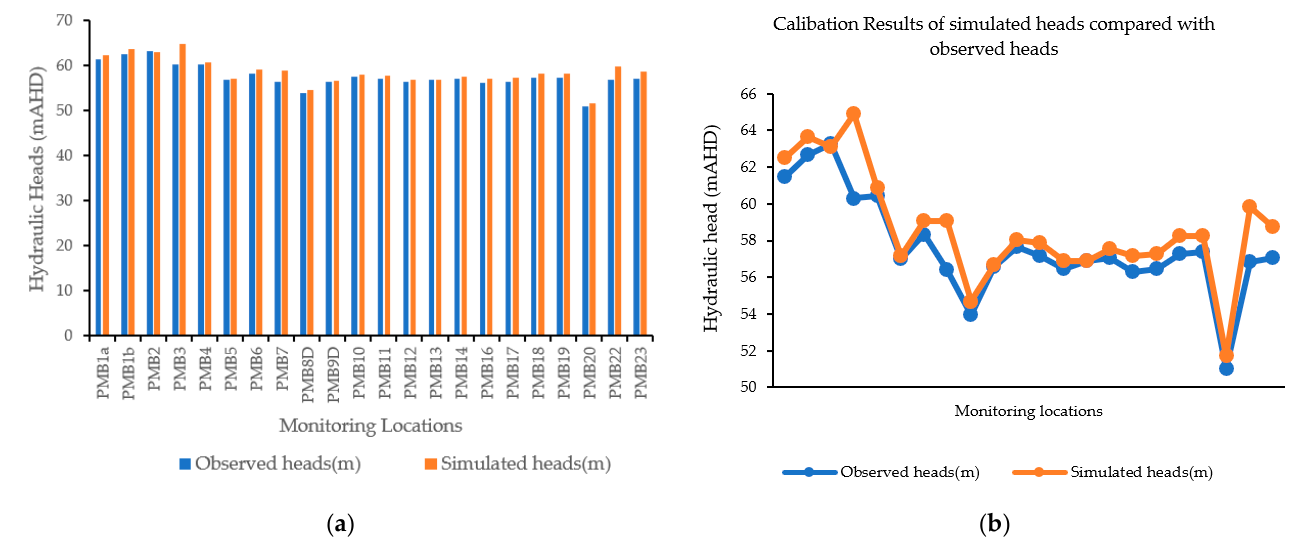
Figure 4. ( a ) Comparison of hydraulic heads observed in 2012 with those estimated by the calibrated model; ( b ) calibrated results of hydraulic heads for 2012.